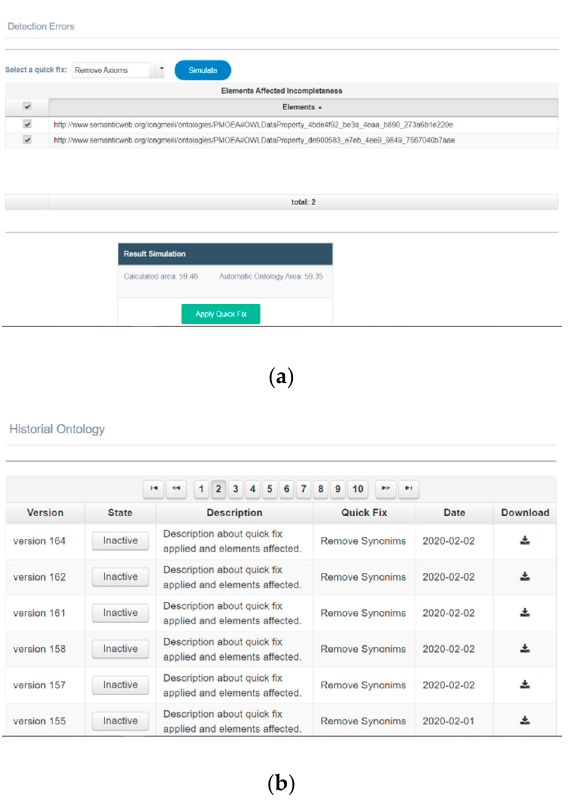
Figure 9. Fixing errors in ontologies. ( a ) Applying a quick fix. ( b ) History of modifications.